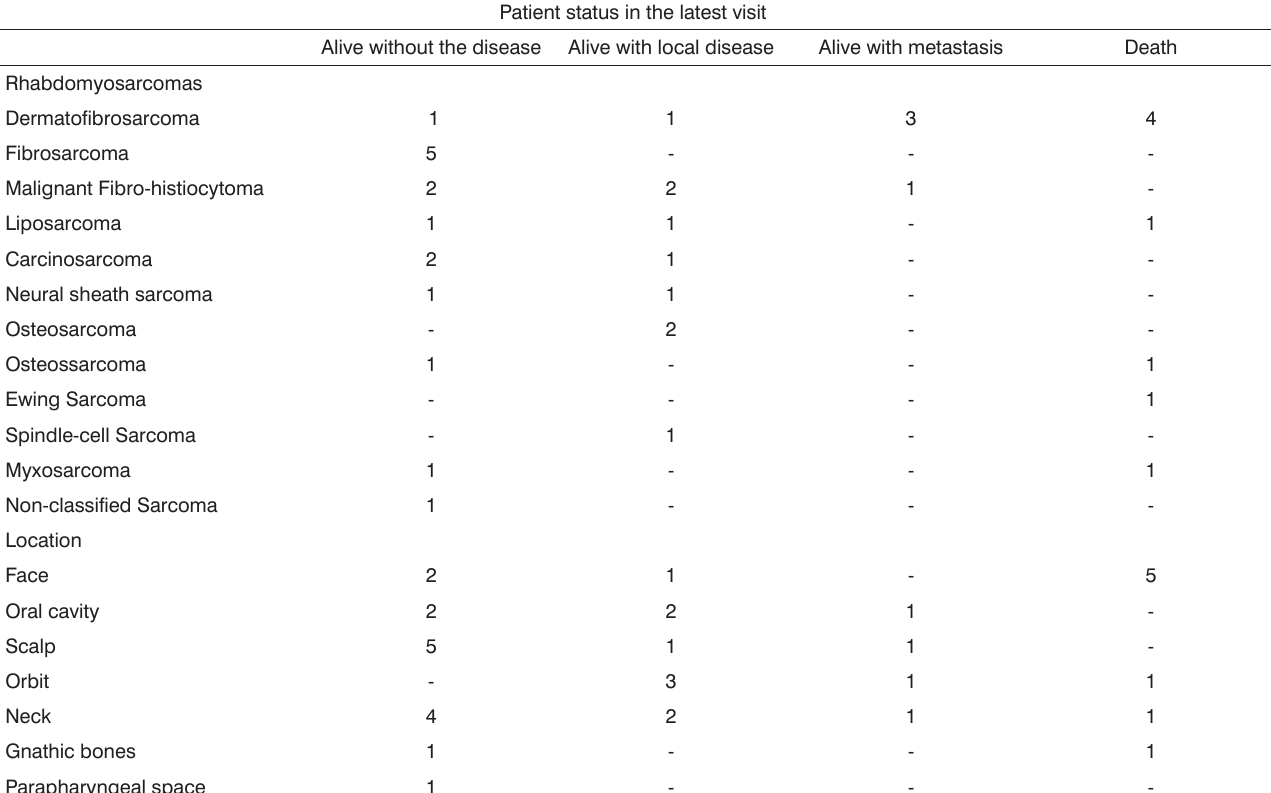
Table 3. Sample distribution according to histological type, location and status in the latest medical visit. Patient status in the latest visit